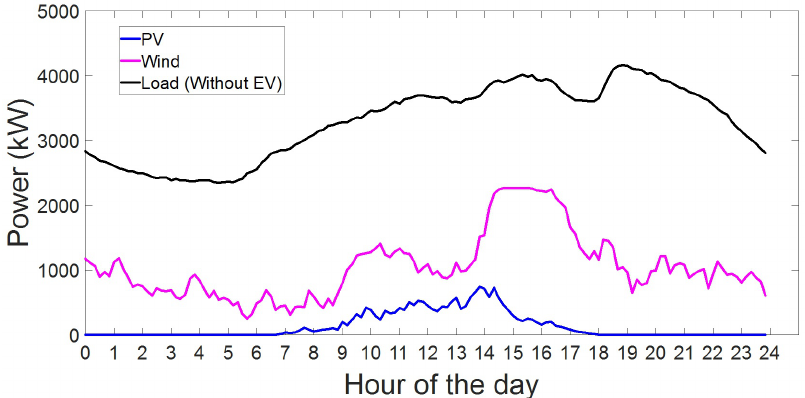
Figure 3. Present daily Santa Cruz load and daily Renewable